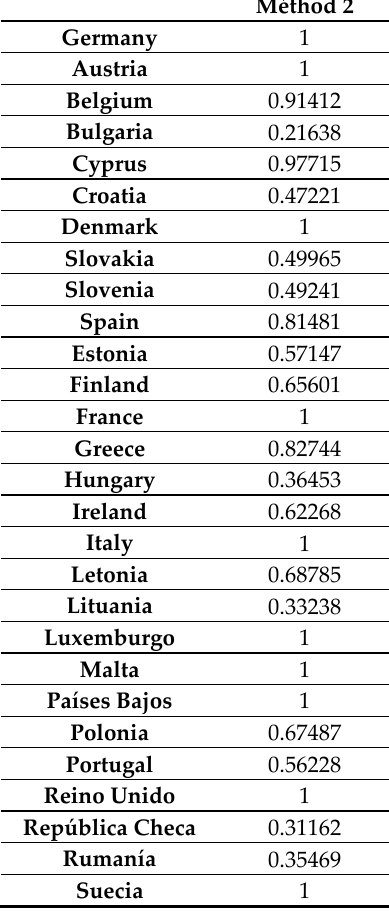
Table 6. Average environmental efficiency data for the 28 countries in the period 2005–2012 obtained with the DEA Method 2. Source: own